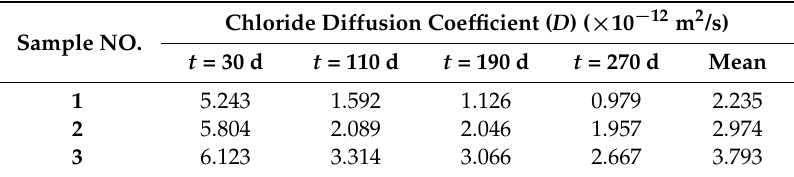
Table 4. Chloride diffusion coefficient, D